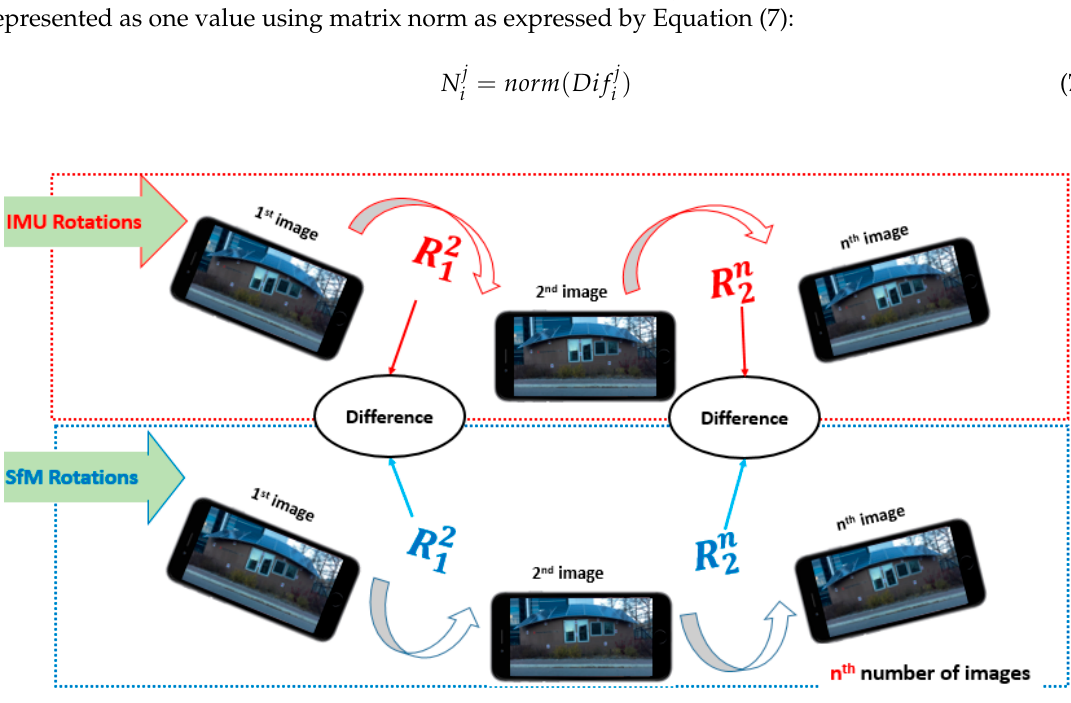
Table 2. The difference between each corresponding relative rotation result.